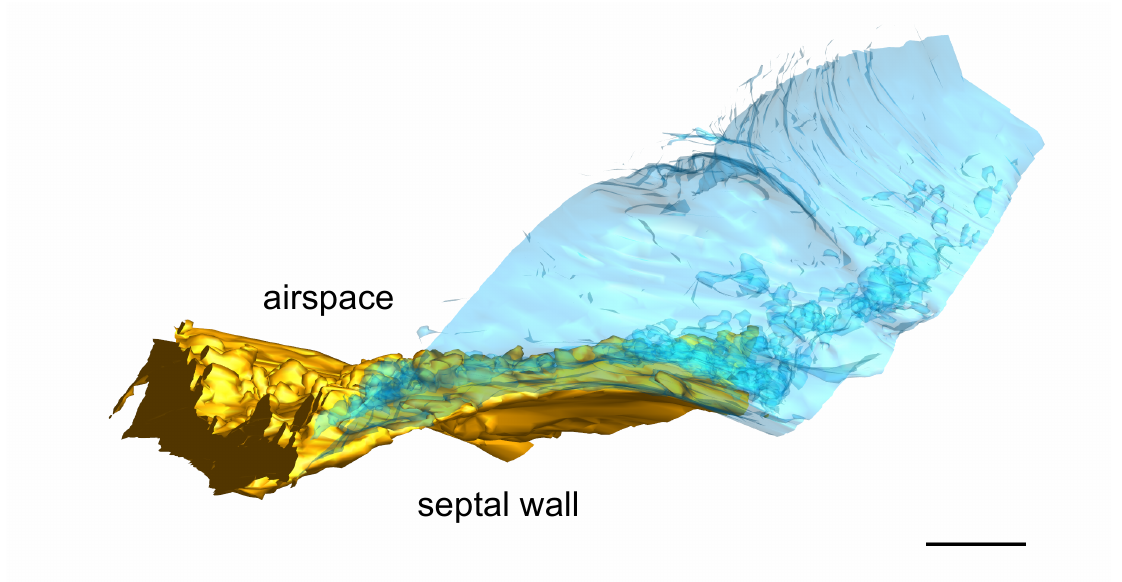
Figure 8. AE1/AE1 contact. The image shows the contact of parts of the yellow and blue AE1 cell domains. The blue cell domain in the foreground is displayed transparently to enable visualization of the yellow AE1 cell domain. Note how the yellow AE1 cell domain slips beneath the blue cell domain. Scale bar: 1 µ m.